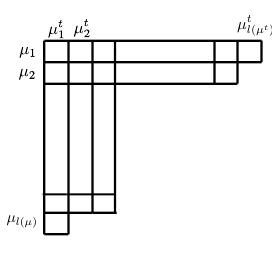
Figure 9 . The Young diagram and its